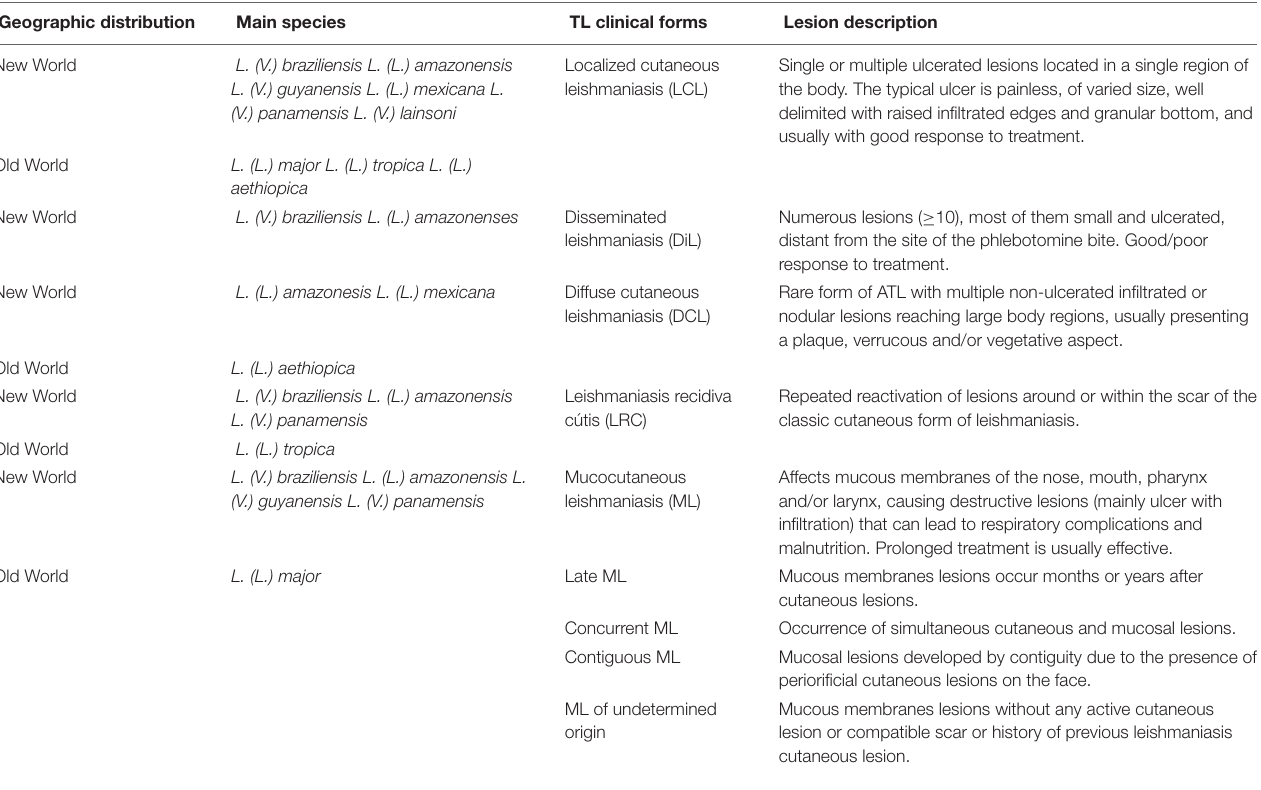
TABLE 1 | Clinical characteristics of lesions and the Leishmania species involved in main clinical forms of TL. Geographic